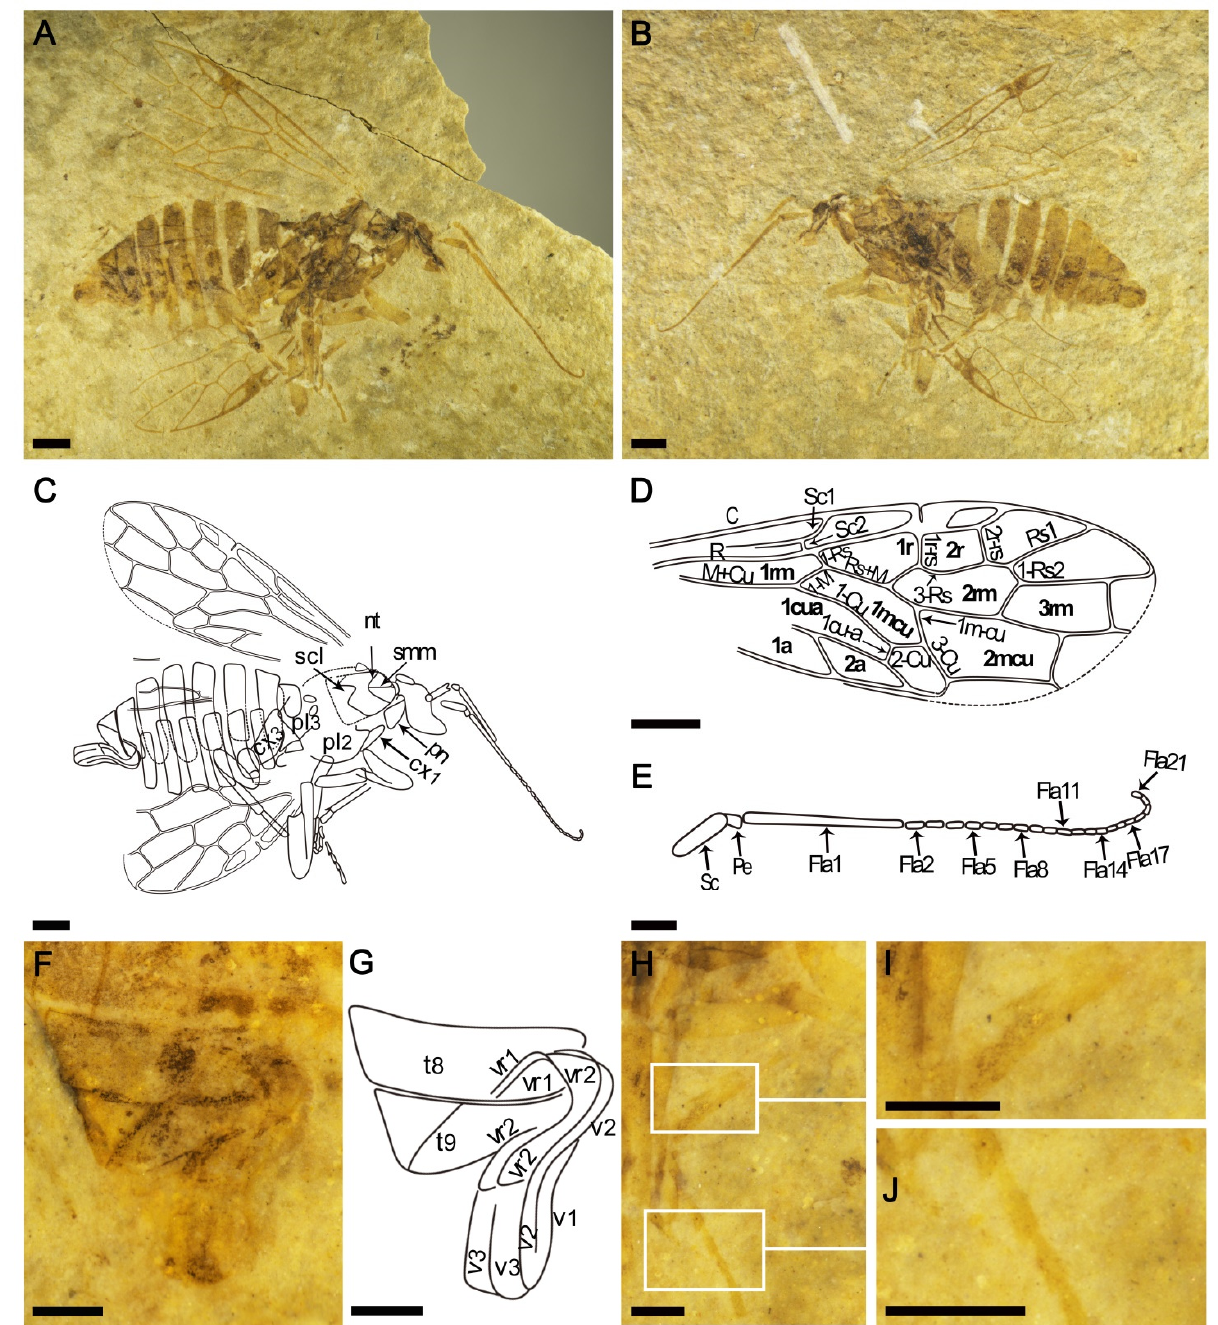
Figure 1. Photographs of Leptoxyela eximia gen. et sp. nov., holotype (specimen CNU-HYM-LB- 2021002) female. ( A , B ), latero-ventral view as preserved. ( C ), line drawing of latero-ventral view. ( D ), line drawing of forewing. ( E ), line drawing of antenna. ( F ), ovipositor under alcohol. ( G ), line drawing of ovipositor. ( H ), middle leg under alcohol. ( I ), middle leg under alcohol, showing leg tibial spurs (white wireframe). ( J ), middle leg under alcohol, showing planter lobes (white wireframe). Scale bars: 1 mm in ( A – D ); 0.5 mm in ( E – J ). Abbreviations: cx 1 —coxa 1 ; cx 3 —coxa 3 ; fla 1 –fla 21 —flagellomeres I-XXI; nt—notaulus; pe—pedicel; pl 2 —mesopleuron; pl 3 —metapleuron; pn—pronotum; sc—scape; scl—mesoscutellum; smm—medial mesoscutal suture; t 8 –t 9 —tergum 8–9;